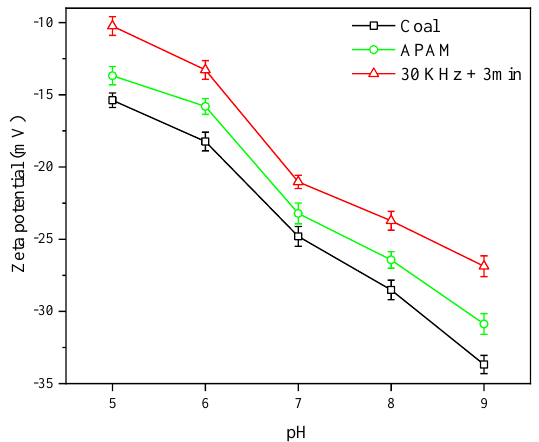
Figure 13. Cha nges of the slurry zeta potential at different pH’s. Figure 13. Changes of the slurry zeta potential at different